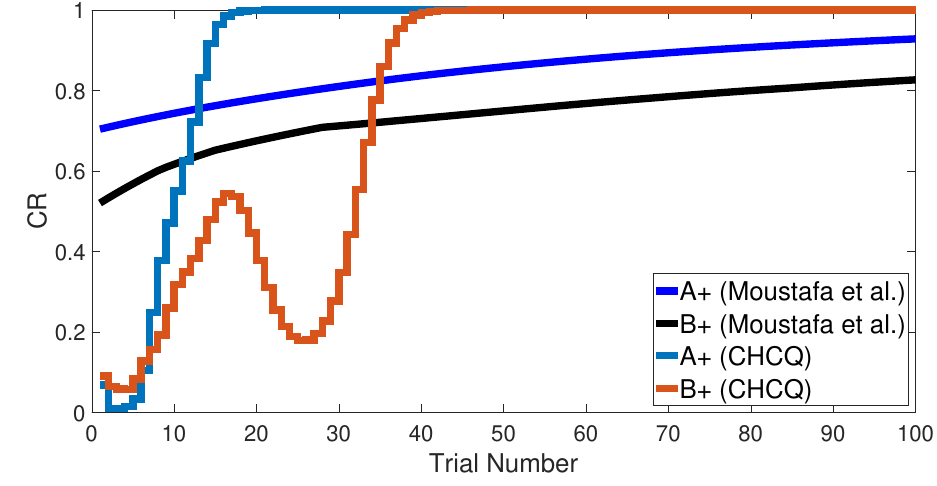
Figure 14. Overshadowing task for the intact